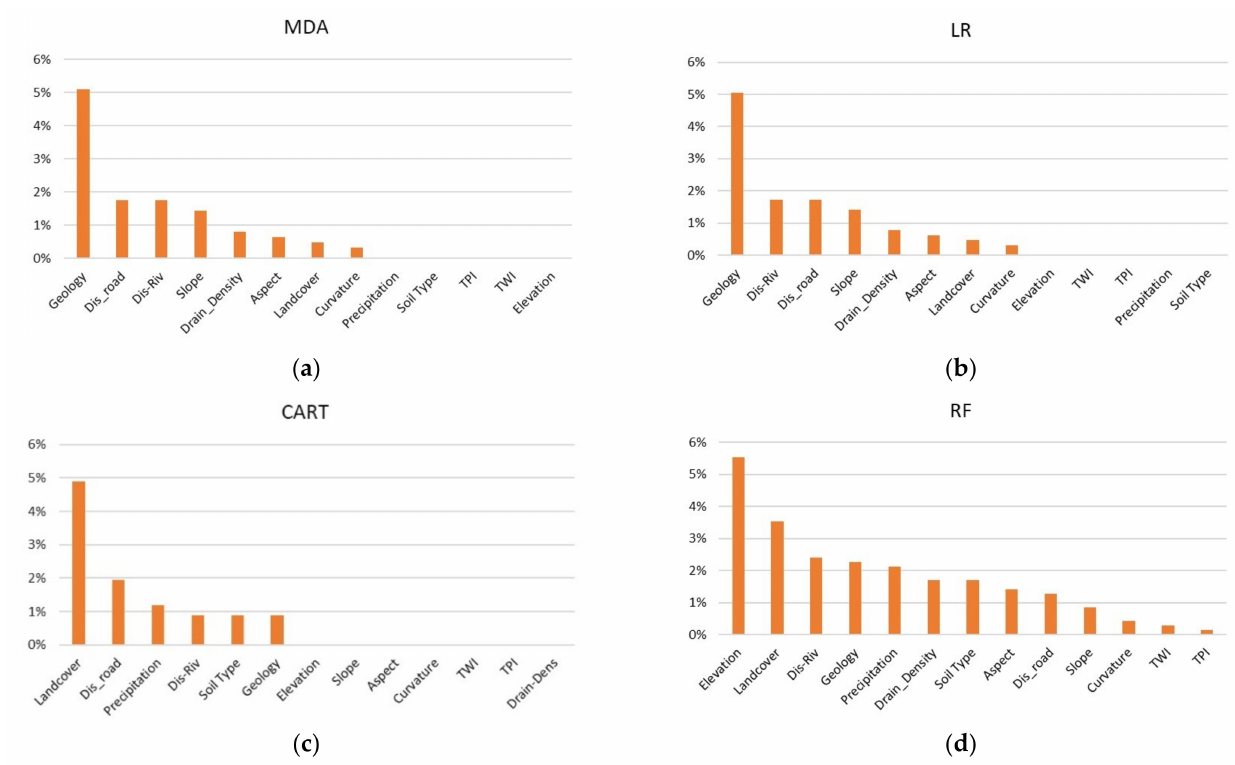
Figure 9. Contribution of descriptive parameters for each model (DACC %, Equation (6)) for ( a ) multivariate discriminant analysis (MDA), ( b ) logistic regression (LR), ( c ) classification and regression tree (CART), and ( d ) random forest